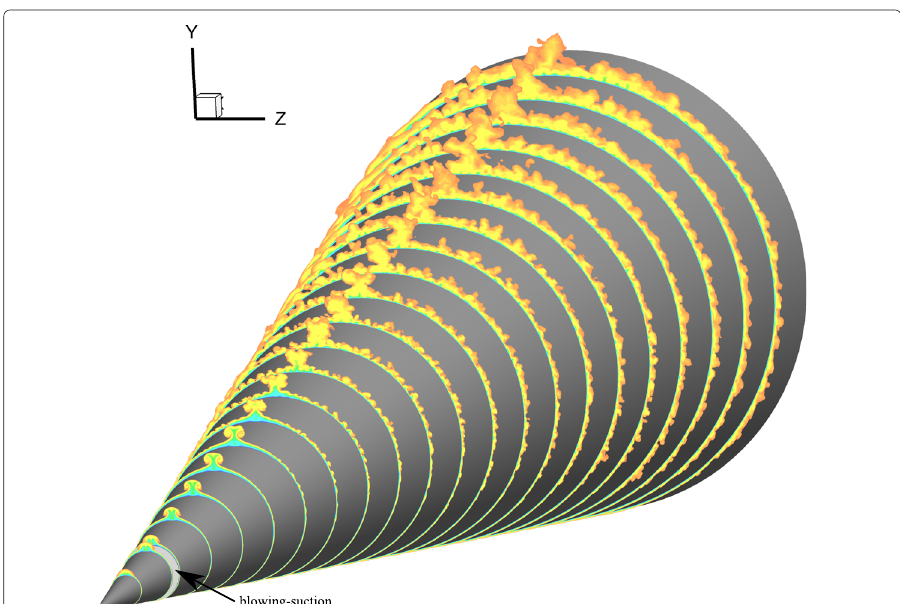
Fig. 3 Contours of instantaneous u in wall-normal planes at several axial locations